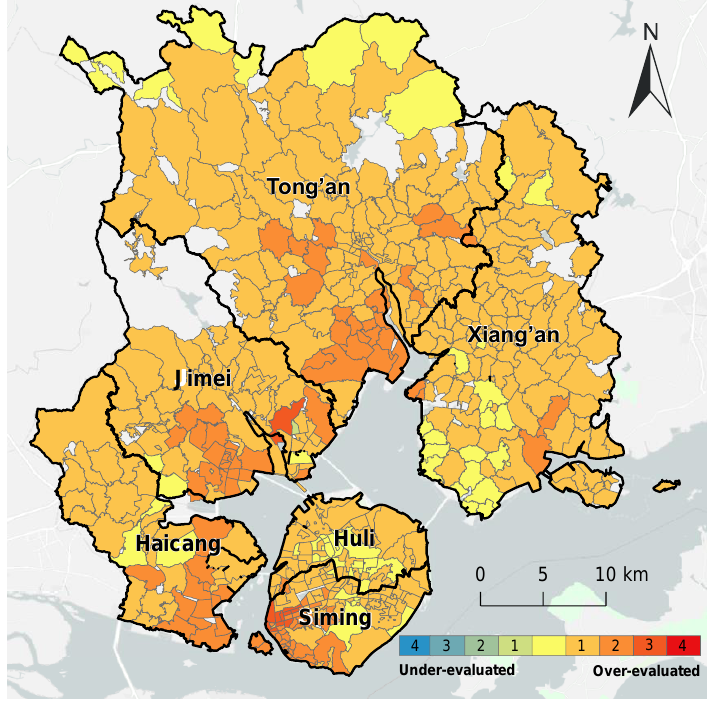
Figure 10. Comparison of the accessibility of gynecology and obstetrics service with the overall accessibility in Xiamen City.